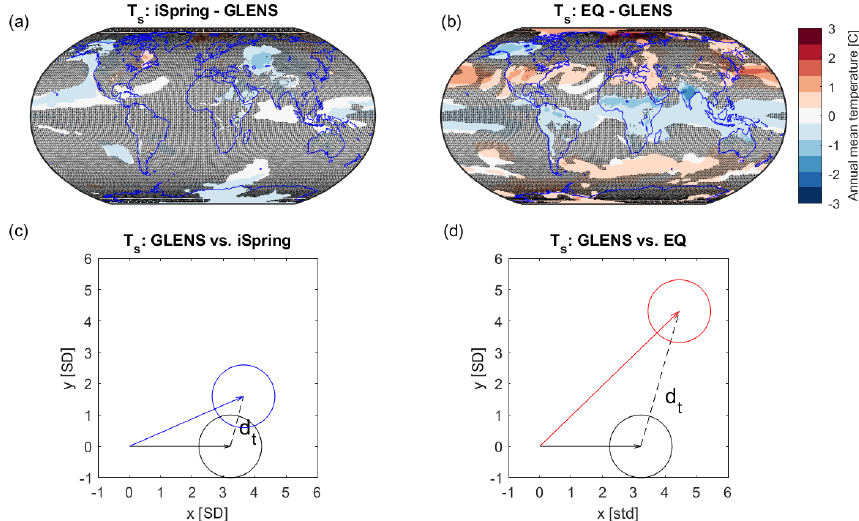
Figure 9. Panels (a, c) show the comparison between GLENS and iSpring; (b, d) show the comparison between GLENS and EQ. Pan- els (a) and (b) show the difference in temperature responses between GLENS and iSpring and between GLENS and EQ, respectively; shaded areas are where no statistically significant difference is observed, based on a t test with a confidence level of 95%. Panels (c) and (d) are de- tectability plots that geometrically show the ability of detecting differences in the temperature responses between GLENS (black) and iSpring (blue) and between GLENS and EQ (red), respectively. The temperature responses are expressed in the number of standard deviations (SDs) of 20-year averages of temperature. Both the x and y axes are distances in the number of standard deviations. The length of each vector represents the area-weighted L 2 norm of surface air temperature response, and the circle represents temperature variability in all possible directions, with a radius of 1SD due to the normalization. The dashed line in panels (c) and (d) measures the temperature distance, d t , between GLENS and iSpring and between GLENS and EQ, respectively. GLENS and EQ have a larger distance in the temperature response, which indicates the difference between GLENS and EQ is more detectable at the same level of